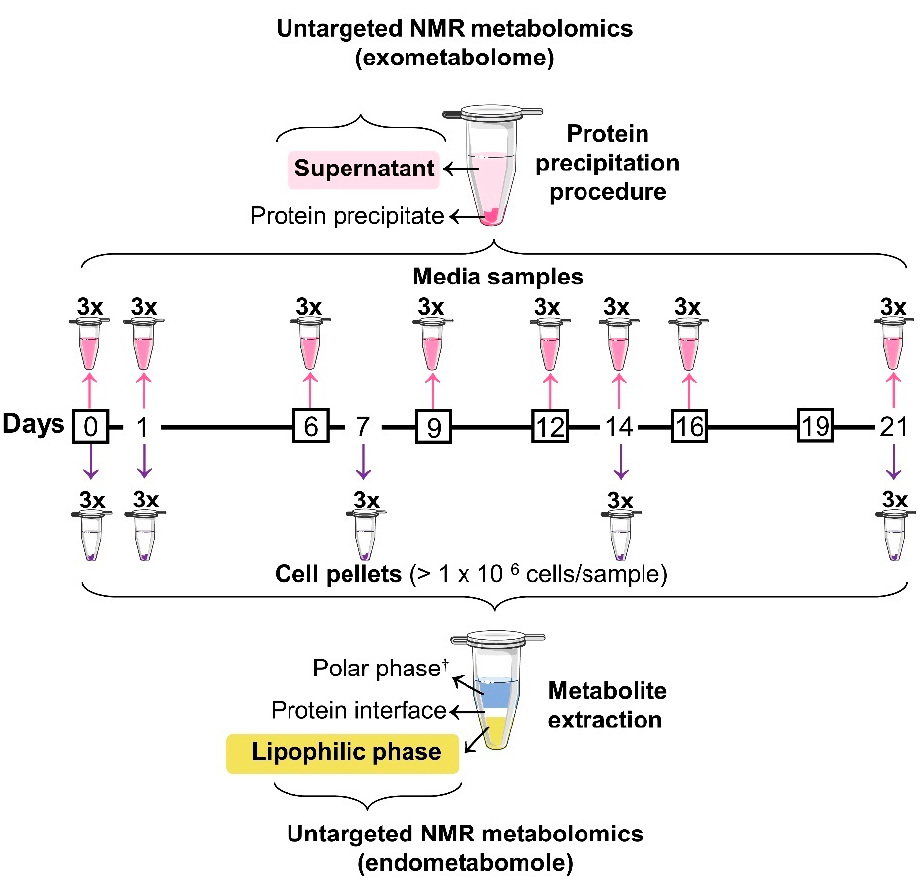
Figure 1. Experimental workflow displaying the osteogenic differentiation timeline (from day 0 to 21). For exometabolome analysis, media samples were collected in triplicate at days 0, 1, 6, 9, 12, 14, 16, and 21 (pink arrows), subjected to a protein-precipitation procedure, and the resulting supernatants were analysed by untargeted 1 H NMR. Cell samples were collected in triplicate at days 0, 1, 7, 14, and 21 (purple arrows), followed by metabolite extraction and subsequent untargeted 1 H NMR analysis of the lipidic phase. The corresponding polar endometabolome ( † ) has already been investigated in [41]. Osteogenic medium was exchanged at days 0, 6, 9, 12, 16, and 19 (black boxes). Some elements were adapted from Servier Medical Art and licensed under a Creative Commons Attribution